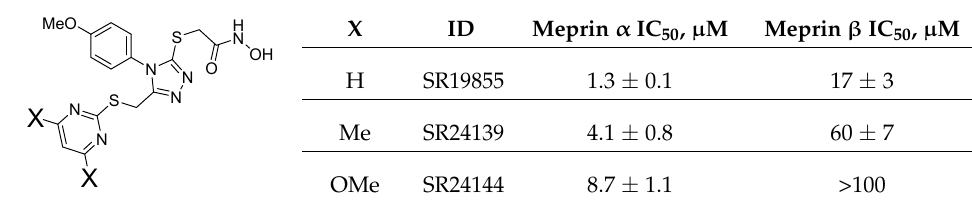
Table 1. Pyrimidine substitution: dimethoxylation disfavors meprin β inhibition.